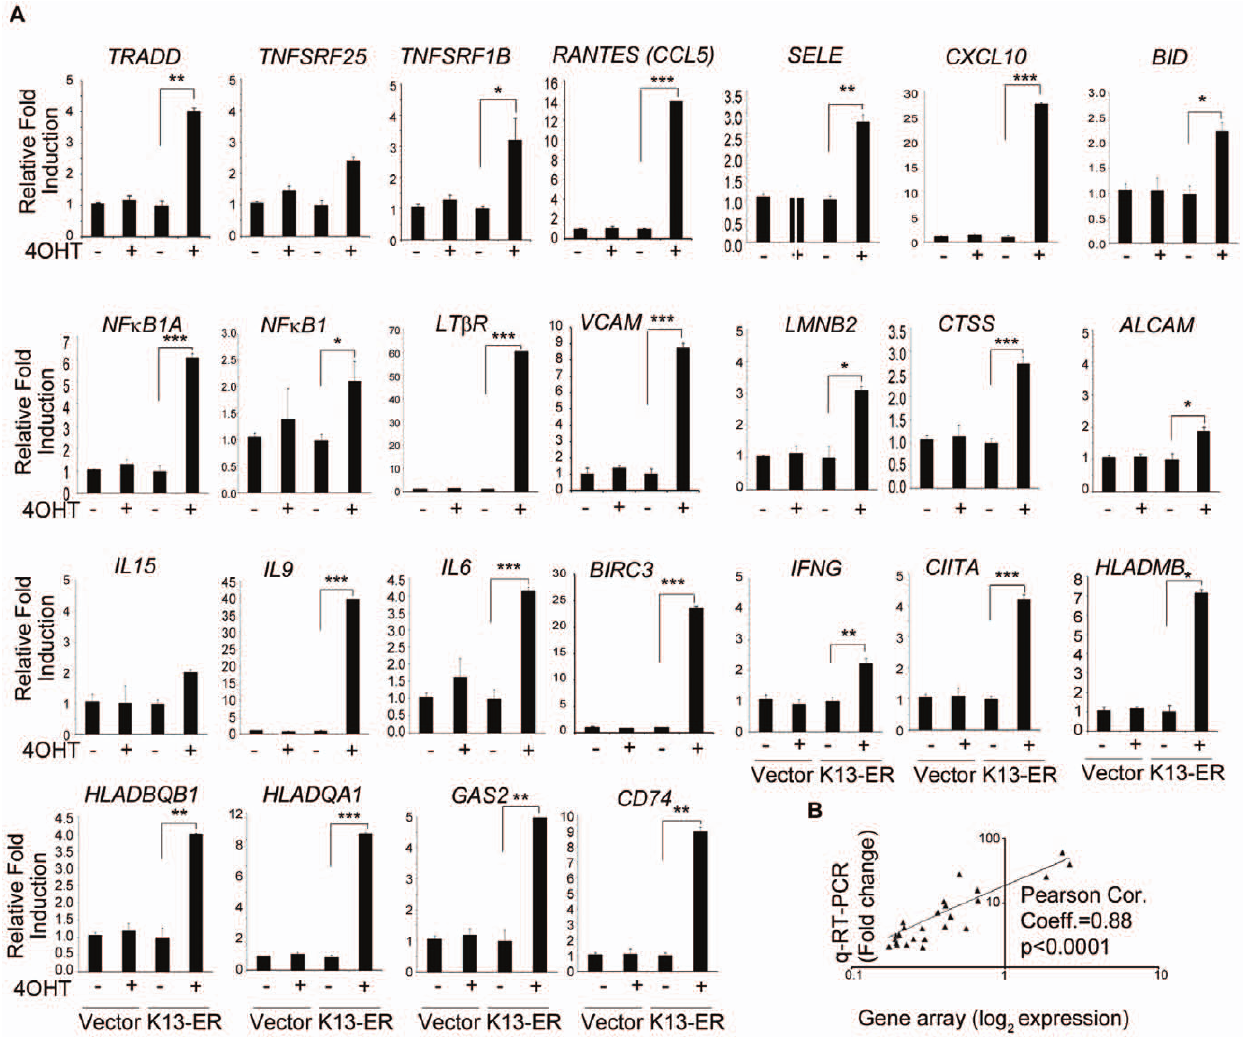
Figure 2. Validation of gene array data by qRT-PCR. (A) Twenty five genes from NF- k B, cytokine, and inflammatory pathways were randomly selected and their relative mRNA levels in mock and 4OHT-treated vector and K13-ER TAM -expressing BCBL1 cells were examined using qRT-PCR. Real- time PCR reactions were performed in triplicate and the data presented as fold change mean 6 S.E in target gene expression (*p , 0.05; Student’s t- test). (B) Pearson Correlation coefficient between gene expression array and real time PCR showed a significant agreement (Correlation coefficient 0.88; p , 0.0001).